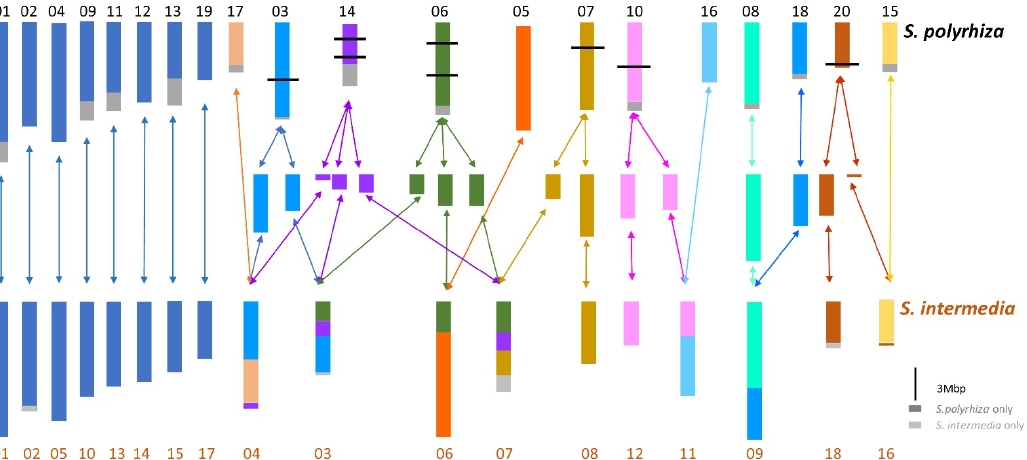
Figure 2. Metaphases with chromosome counts reported for the first time in this paper. To count clearly the chromosome number, image stacks from spatial super-resolution structured illumination